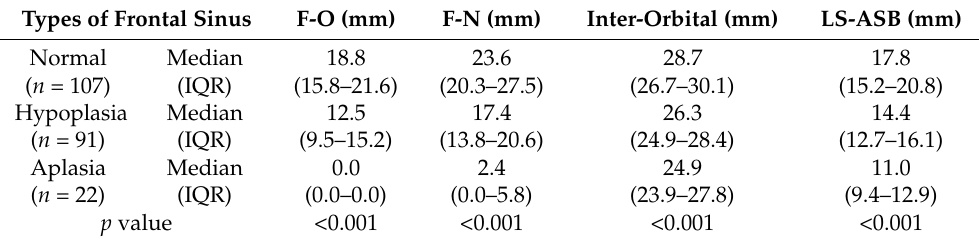
Table 2. F-O, F-N, inter-orbital distance, and LS-ASB in different groups.